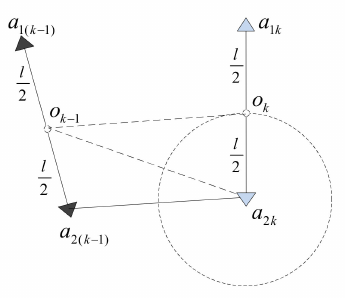
Figure 5. Scenario for positioning when only one of the antennas can detect enough tags.